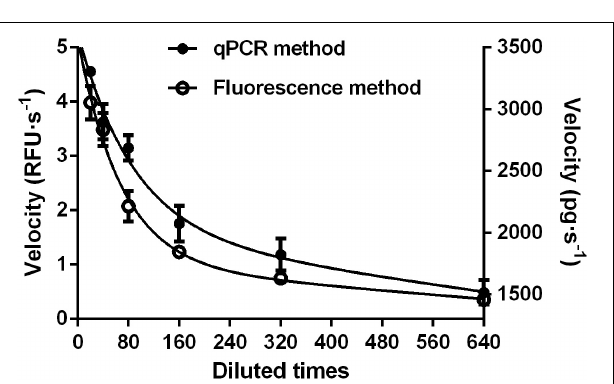
FIGURE 4 | Comparison of fluorescent (Left) and qPCR (Right) methods for analyzing dsRNA degrading nucleases in S. litura gut fluid. Serial dilutions of the gut fluid (20, 40, 80, 160, 320, and 640 times) were incubated with 1 µ L 24 bp fluorescence labeled dsEGFP or 1 µ L 414 bp naked dsEGFP in a total volume of 20 µ L at 37 ◦ C. The final substrate concentration was 0.5 µ M for fluorescence method and 0.05 µ g/ µ L for qPCR method. Values are mean ± SE; n =